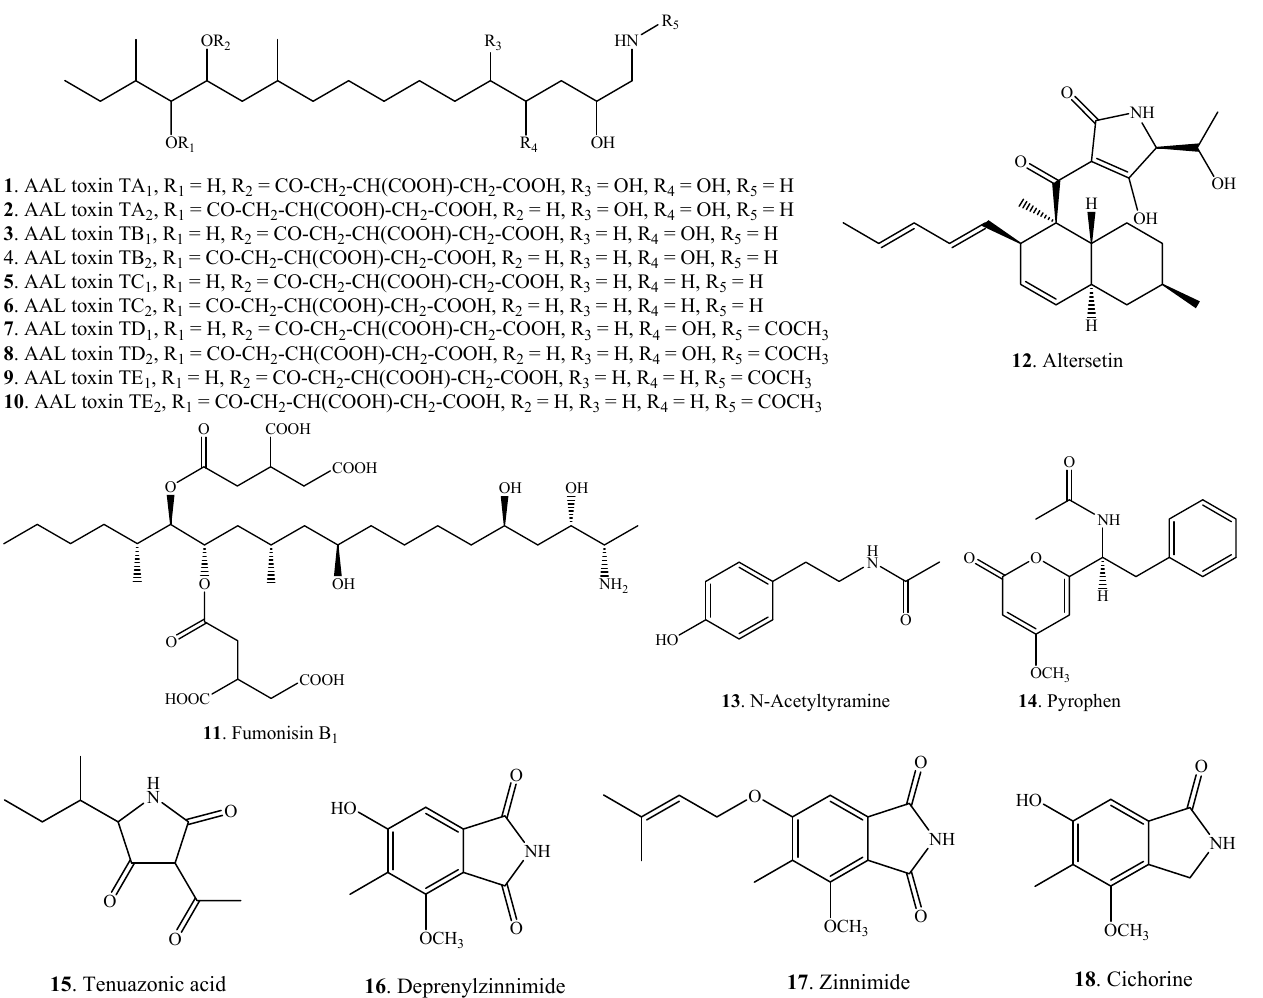
Figure 1. Amines and amides isolated from Alternaria